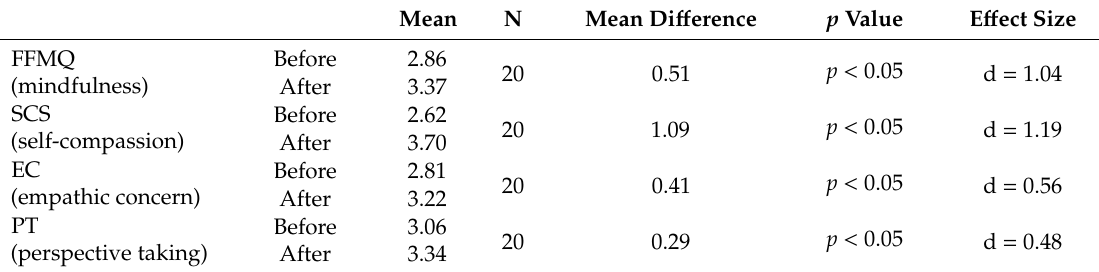
Table 2. Means, p -value, and e ff ect size of the mindfulness